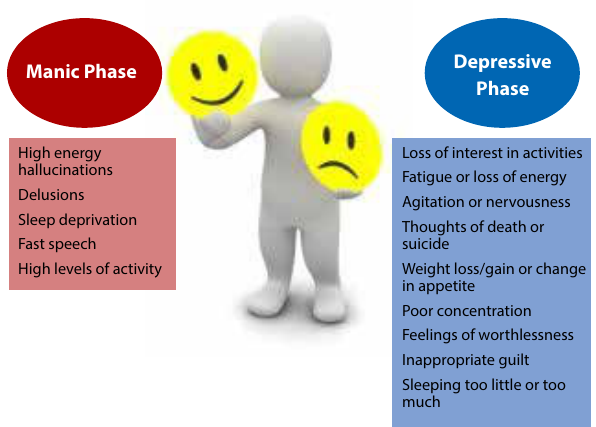
Figure 1: Signs and symptoms of the manic and depressive phases of bipolar